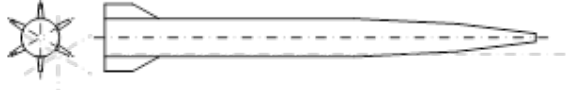
Figure 1. The appearance of the ultrahigh-speed vehicle.